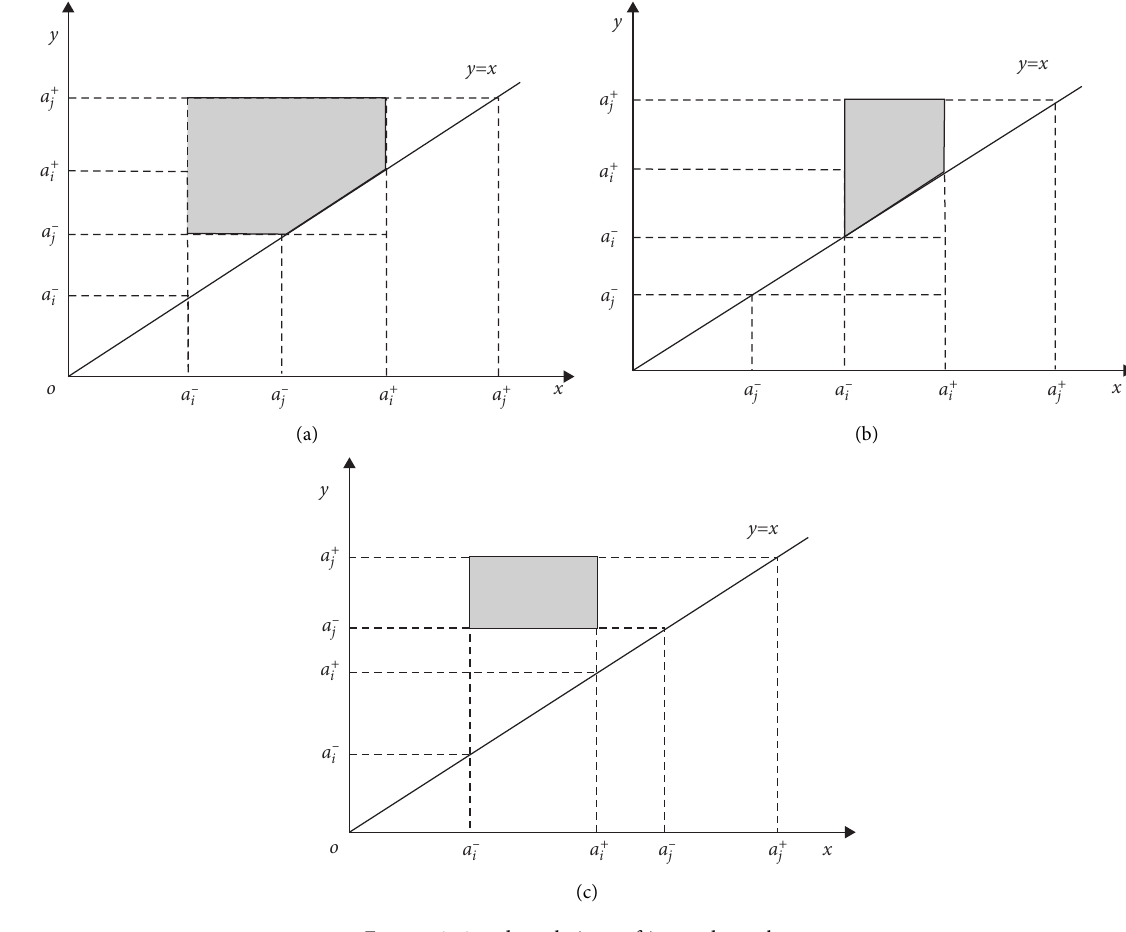
Figure 3: 3 order relations of interval